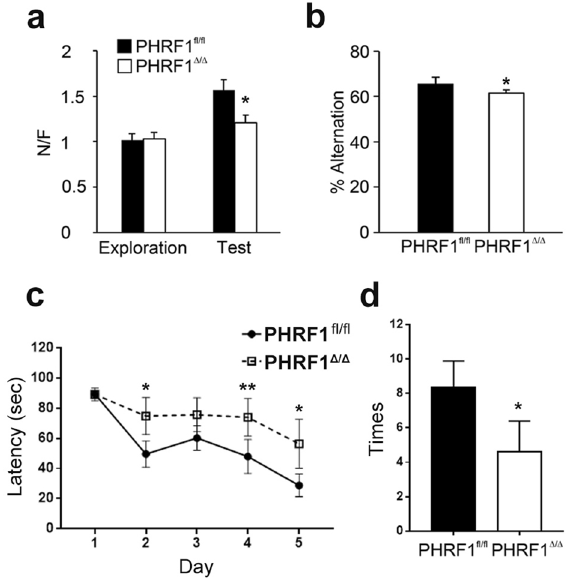
Figure 3. Learning and memory test in PHRF1 Δ/Δ mice. ( a ) Novel object recognition. In the test phase, the discrimination ratio of the familiar object and novel object were quantified (n = 5, all males). ( b ) Y-maze test. Each mouse was placed at the end of one arm and allowed to move freely through the maze during an 8-min session; the number of alternations were analyzed. Data are mean ± SEM. *p < 0.05, two-tailed unpaired Student t-test. (PHRF1 fl/fl n = 13, 11 males, 2 females; PHRF1 Δ/Δ n = 12, 9 males, 3 females) ( c ) An individual mouse in